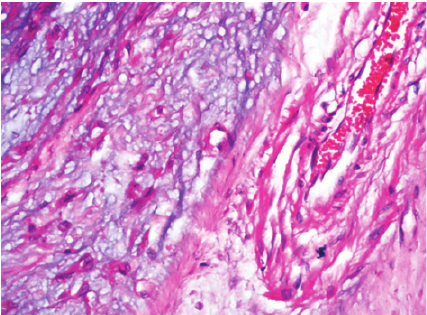
Figure 3: Tumour cells invading the muscles (H & E ×